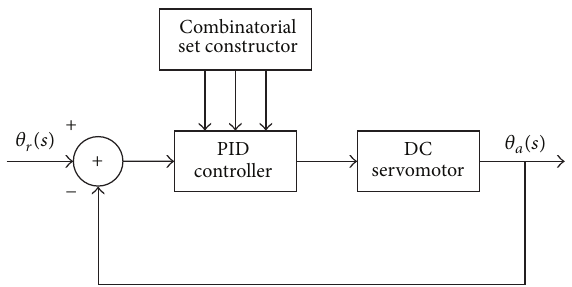
Figure 1: DC servomotor with PID controller tuned by combinato- rial set